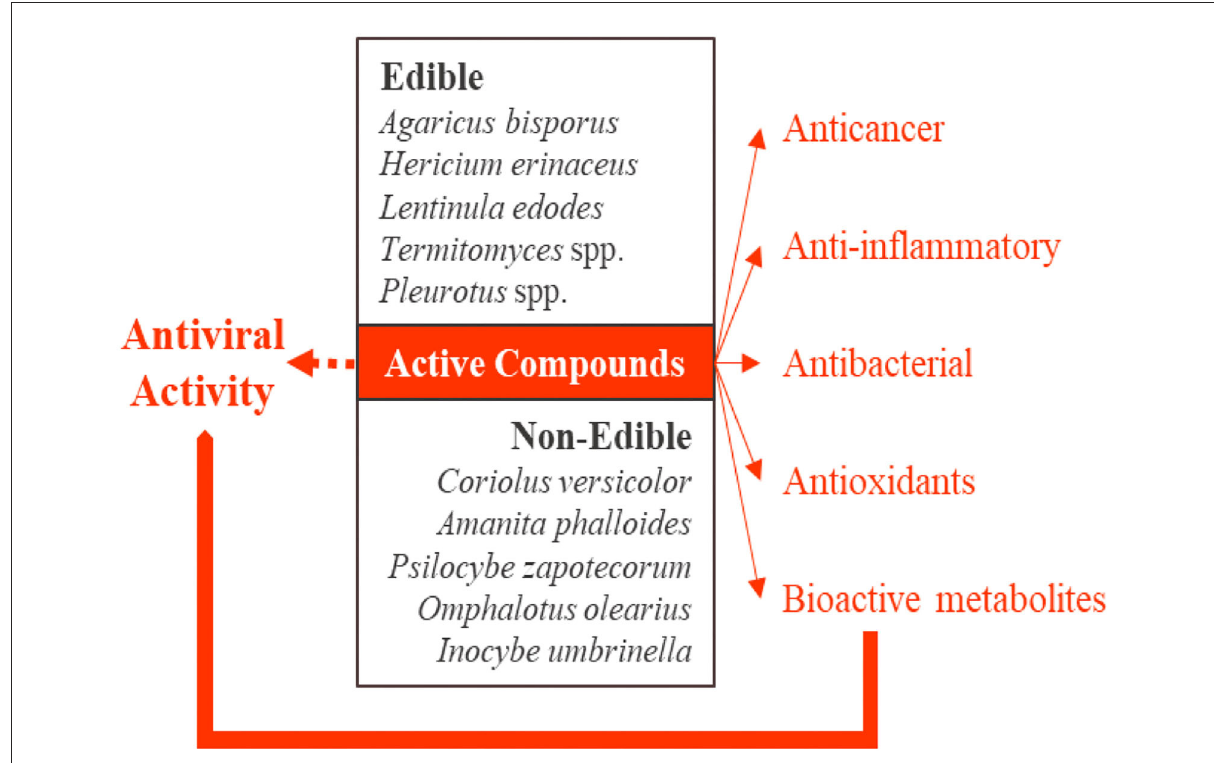
FIGURE7 With several 100 bioactive compounds, mushrooms demonstrate antiviral outcomes and are used as dietary supplements, functional food, or medicinal products.